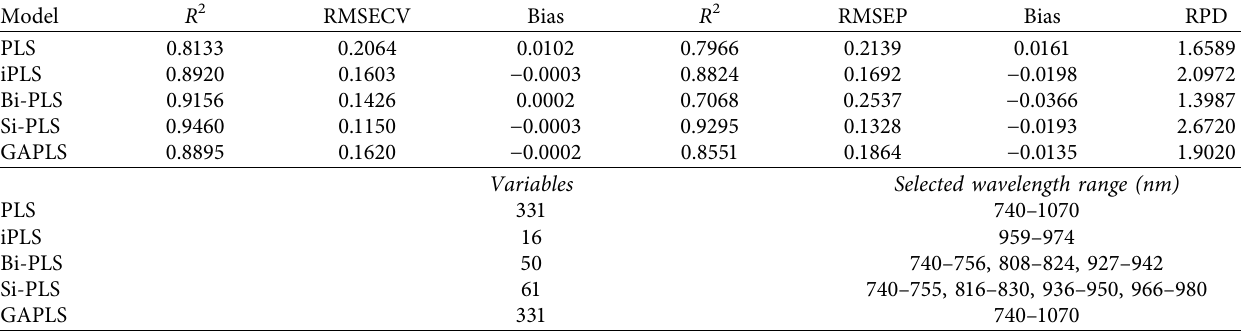
Figure 8: Si-PLS spectra selection: (a) and model plots (b) for NIR estimation and measured value. Table 6: Optimum simultaneous quantifcation of fertilizers A and B adulteration levels.